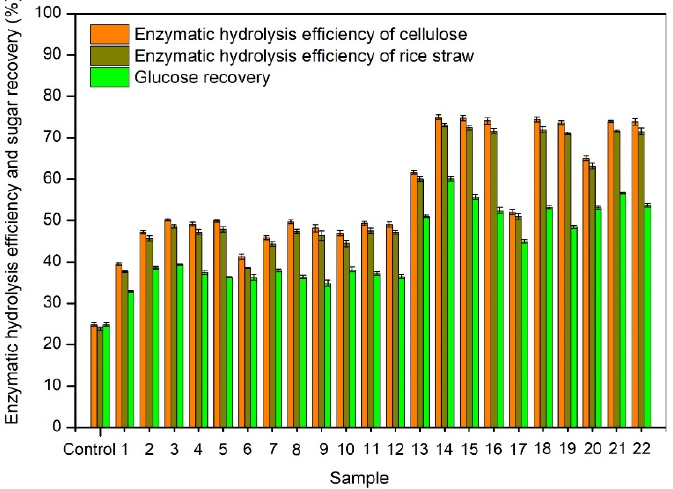
Figure 2. Enzymatic hydrolysis efficiency of cellulose, enzymatic hydrolysis efficiency of straw samples, and glucose recovery of straw samples before and after LHW and LHW-PTA pretreatment.